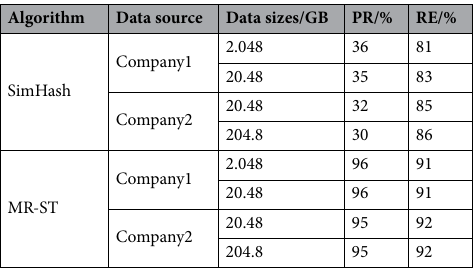
Table 3. The impact of the amount of data on the algorithms.